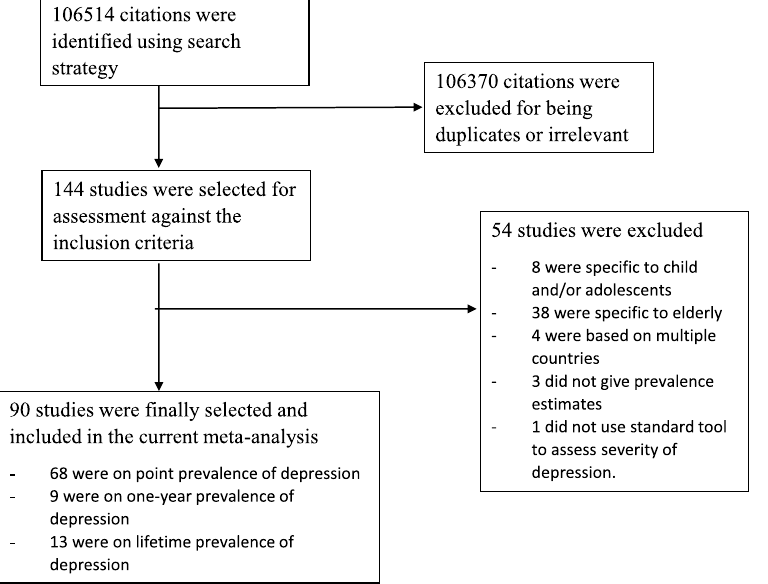
Figure 1. Review and meta-analysis flow